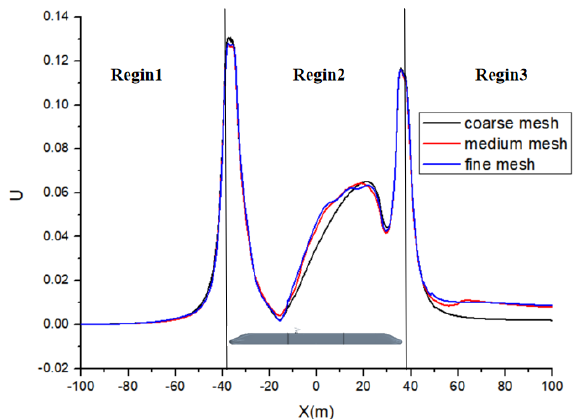
Figure 6. The distribution non-dimensional time-averaged slipstream